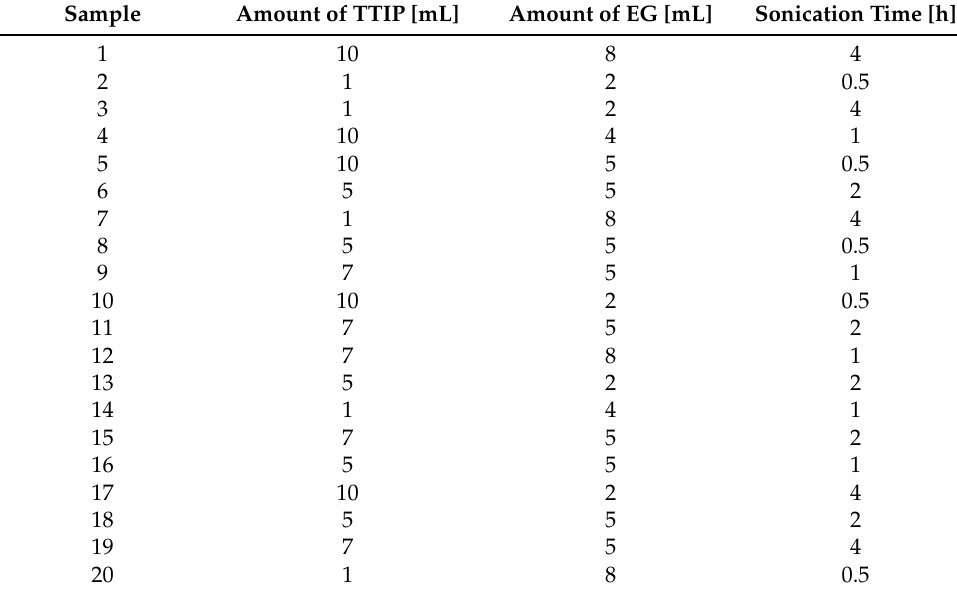
Table 1. Experimental design and variables for the synthesis of TiO 2 NPs.